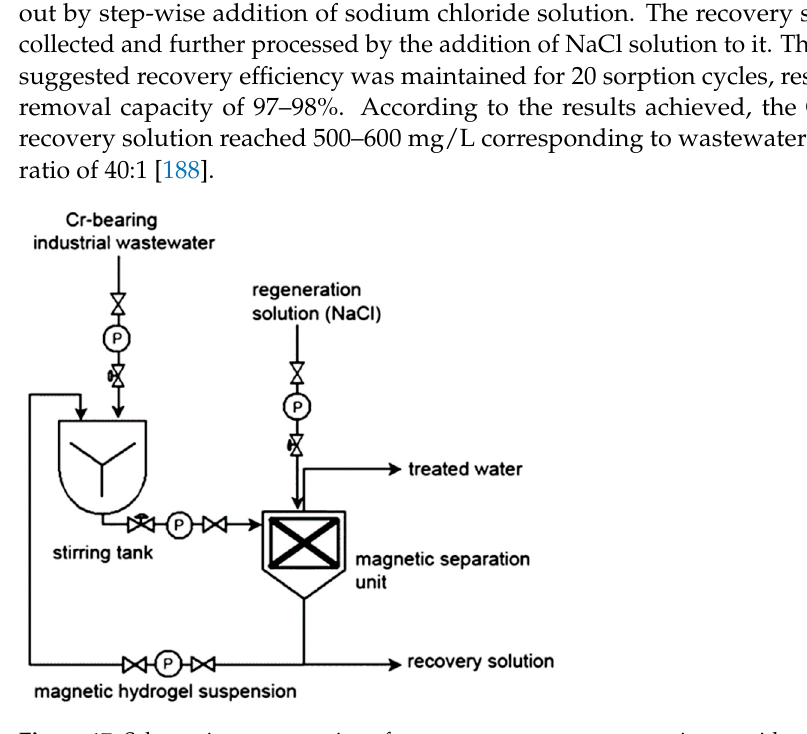
Figure 17. Schematic representation of a wastewater treatment experiment with a magnetic separation unit. (Reprinted with permission from Ref. [188]. Copyright 2022 Americal Chemical Society).